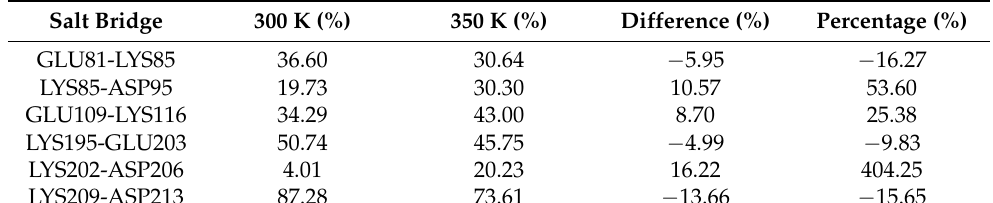
Table 2. The salt bridge with a probability of not less than 20% before and after heating up as well as the difference and percentage of change between before and after heating up.